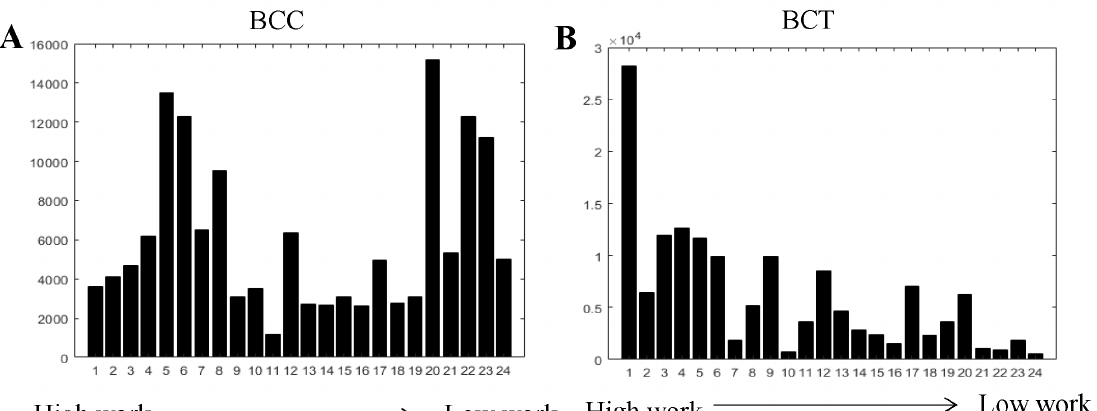
Figure 4. Histograms of the variants’ occurrence considering the BCC model in ( A ) and the BCT model in ( B ). In the y -axis: the number of pixels associated with a given variant number. In x -axis: variants numbered with a ranking according to the value of the